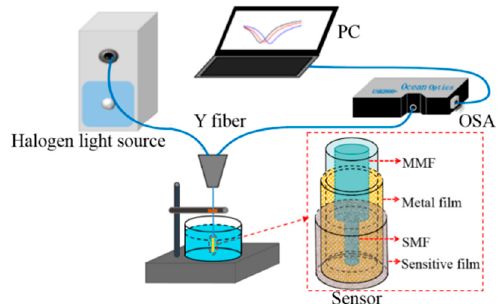
Figure 6. Reflective fiber SPR Hg 2+ measurement system.